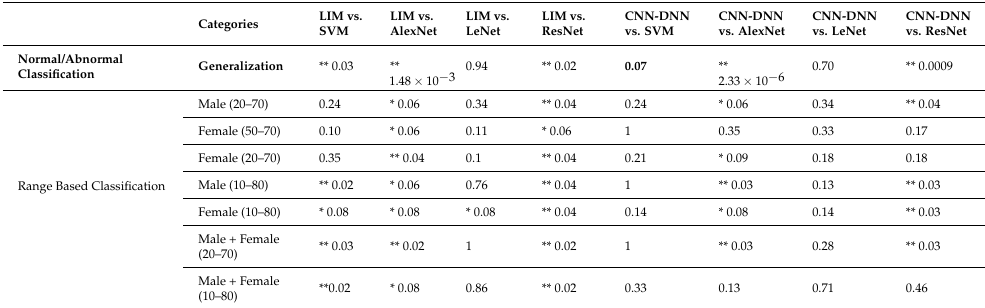
Table 11. Statistical test (ANOVA) of LIM and CNN-DNN with respect to SVM, LeNet, AlexNet, and ResNet where values marked as ** are p -values < 0.05 and * are p -values <